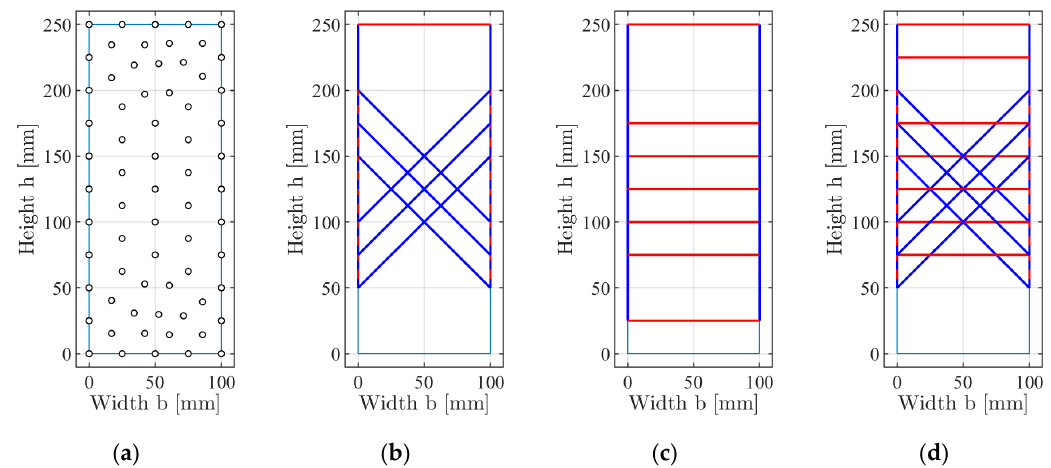
Figure 4. Collapse mechanisms (blue: Slip displacements, red: Normal displacements) from DLO for the tensile specimen: ( a ) Nodes; ( b ) slip line mechanism; ( c ) yield zone mechanism; ( d ) combined slip line and yield zone mechanism.